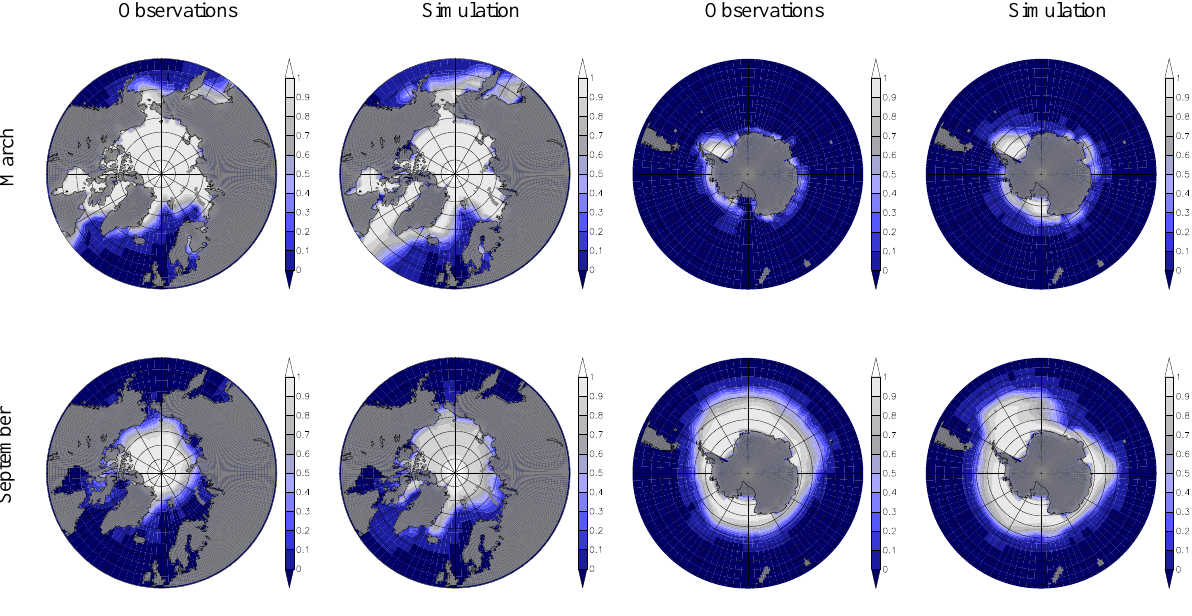
Fig. 10. Simulated and observed polar ice coverage. The upper and lower rows show March and September, respectively. Observations and results from simulation TRANS are averaged for the years 1960–1990. Observations are from the HadISST (Rayner et al., 2003) data set.